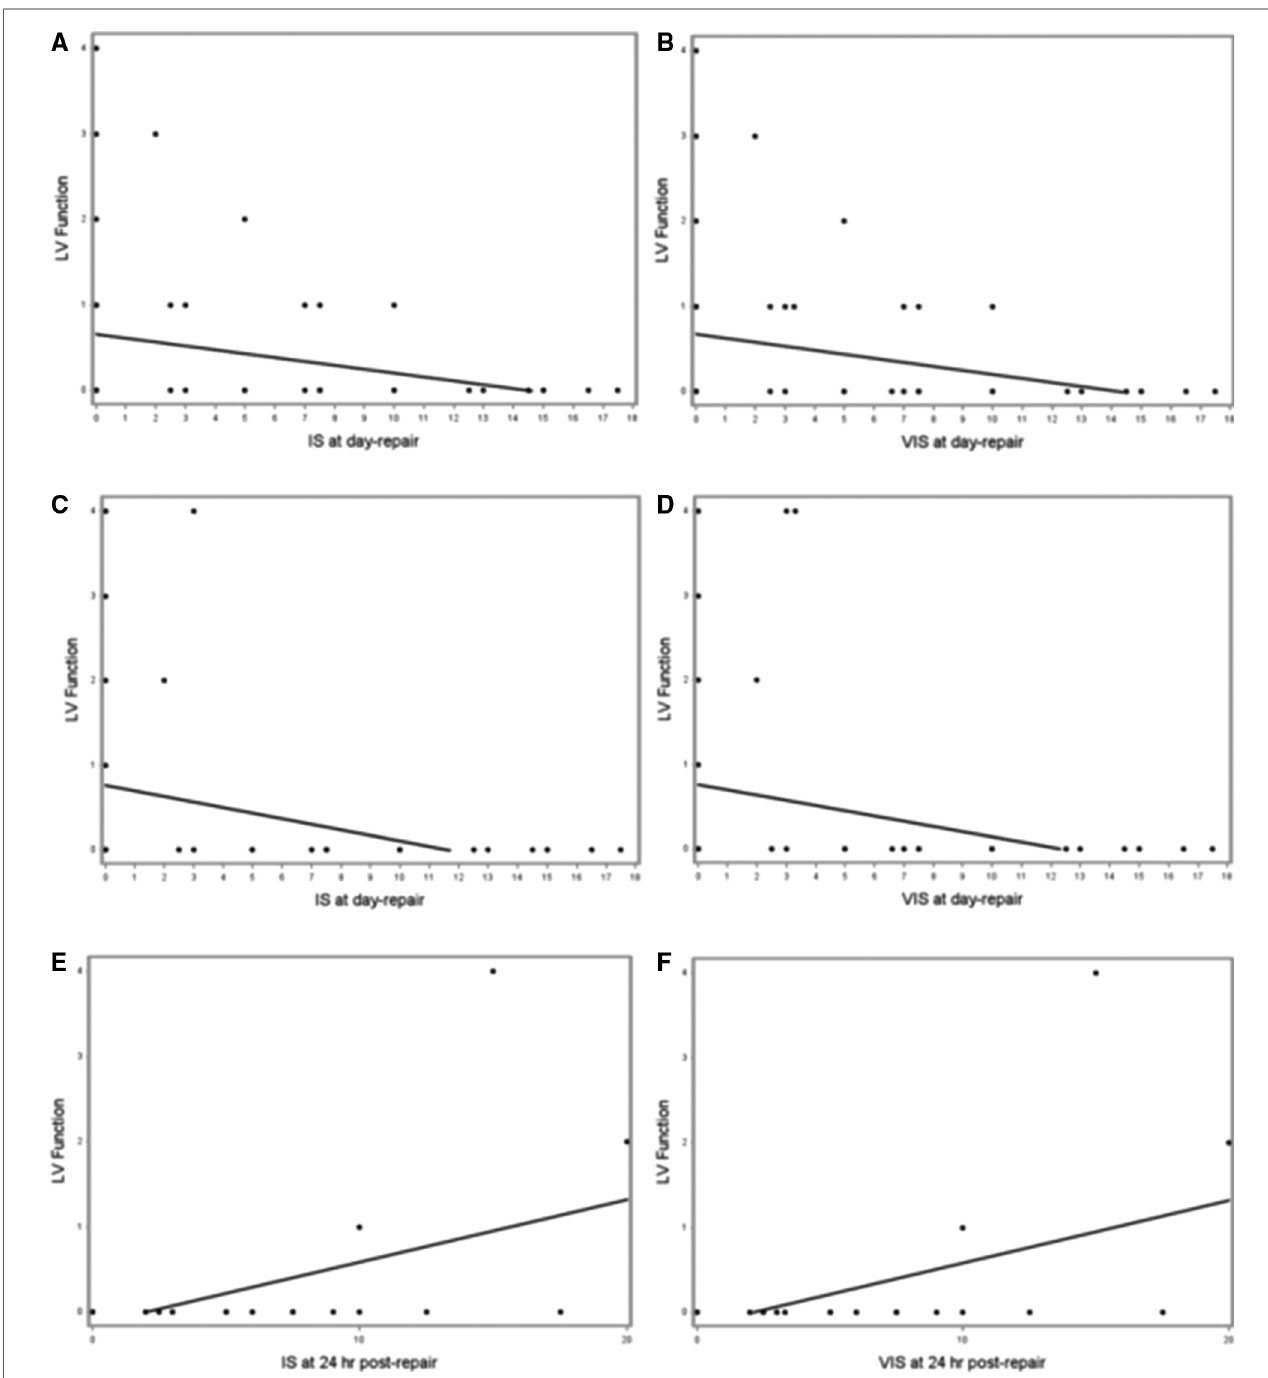
FIGURE 2 ( A – F ). Scatterplots of IS and VIS on the day of repair vs. LV function in fi rst postnatal echocardiogram ( A and B , respectively), IS and VIS on the day of repair vs. LV function in post-repair echocardiogram ( C and D , respectively), and IS and VIS at 24 h following repair vs. LV function in 28-day echocardiogram ( E and F ,